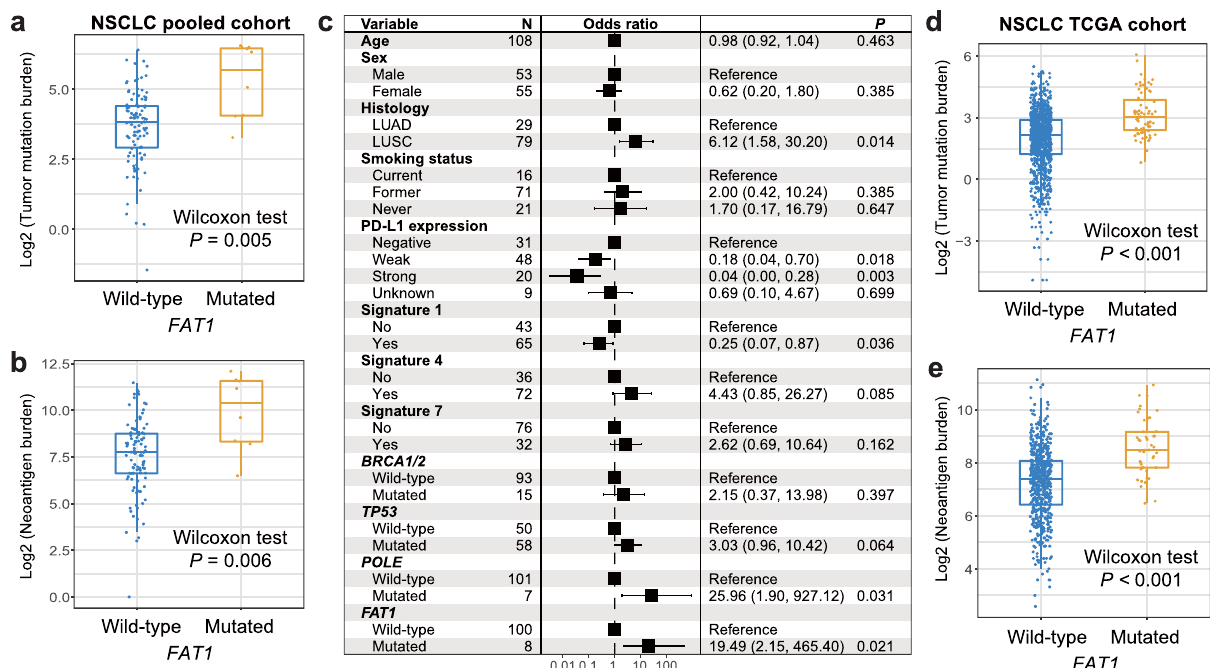
Fig. 5 Association of FAT1 mutations with mutation burden in NSCLC. a Distinct distribution of TMB in FAT1 mutated versus wild-type patients in the integrated NSCLC cohort. Blue dot, TMB for wild-type patients; orange dot, TMB for mutated patients. b Multivariate logistic regression model between FAT1 mutations and TMB with clinical confounding factors, extracted mutational signatures, and mutations in DNA repair genes taken into consideration. c Distinct distribution of NB in FAT1 mutated versus wild-type patients in the integrated NSCLC cohort. Black box: odds ratio; black scale bar, 95% con fi dence interval of odds ratio. Distinct distribution of ( d ) TMB and ( e ) NB in FAT1 mutated versus wild-type NSCLC patients from TCGA cohort.